Question: Does the figure show an increasing or a decreasing trend?
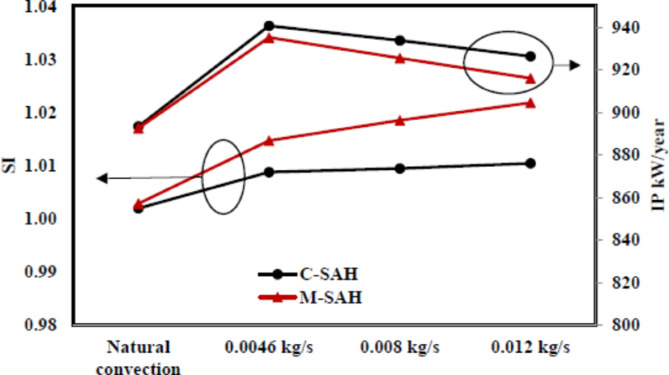
Answer: increasing